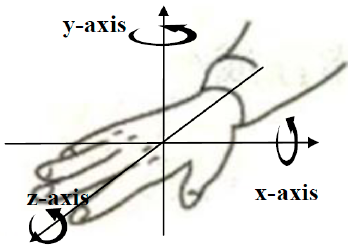
Figure 7. Three typical axis subclasses.